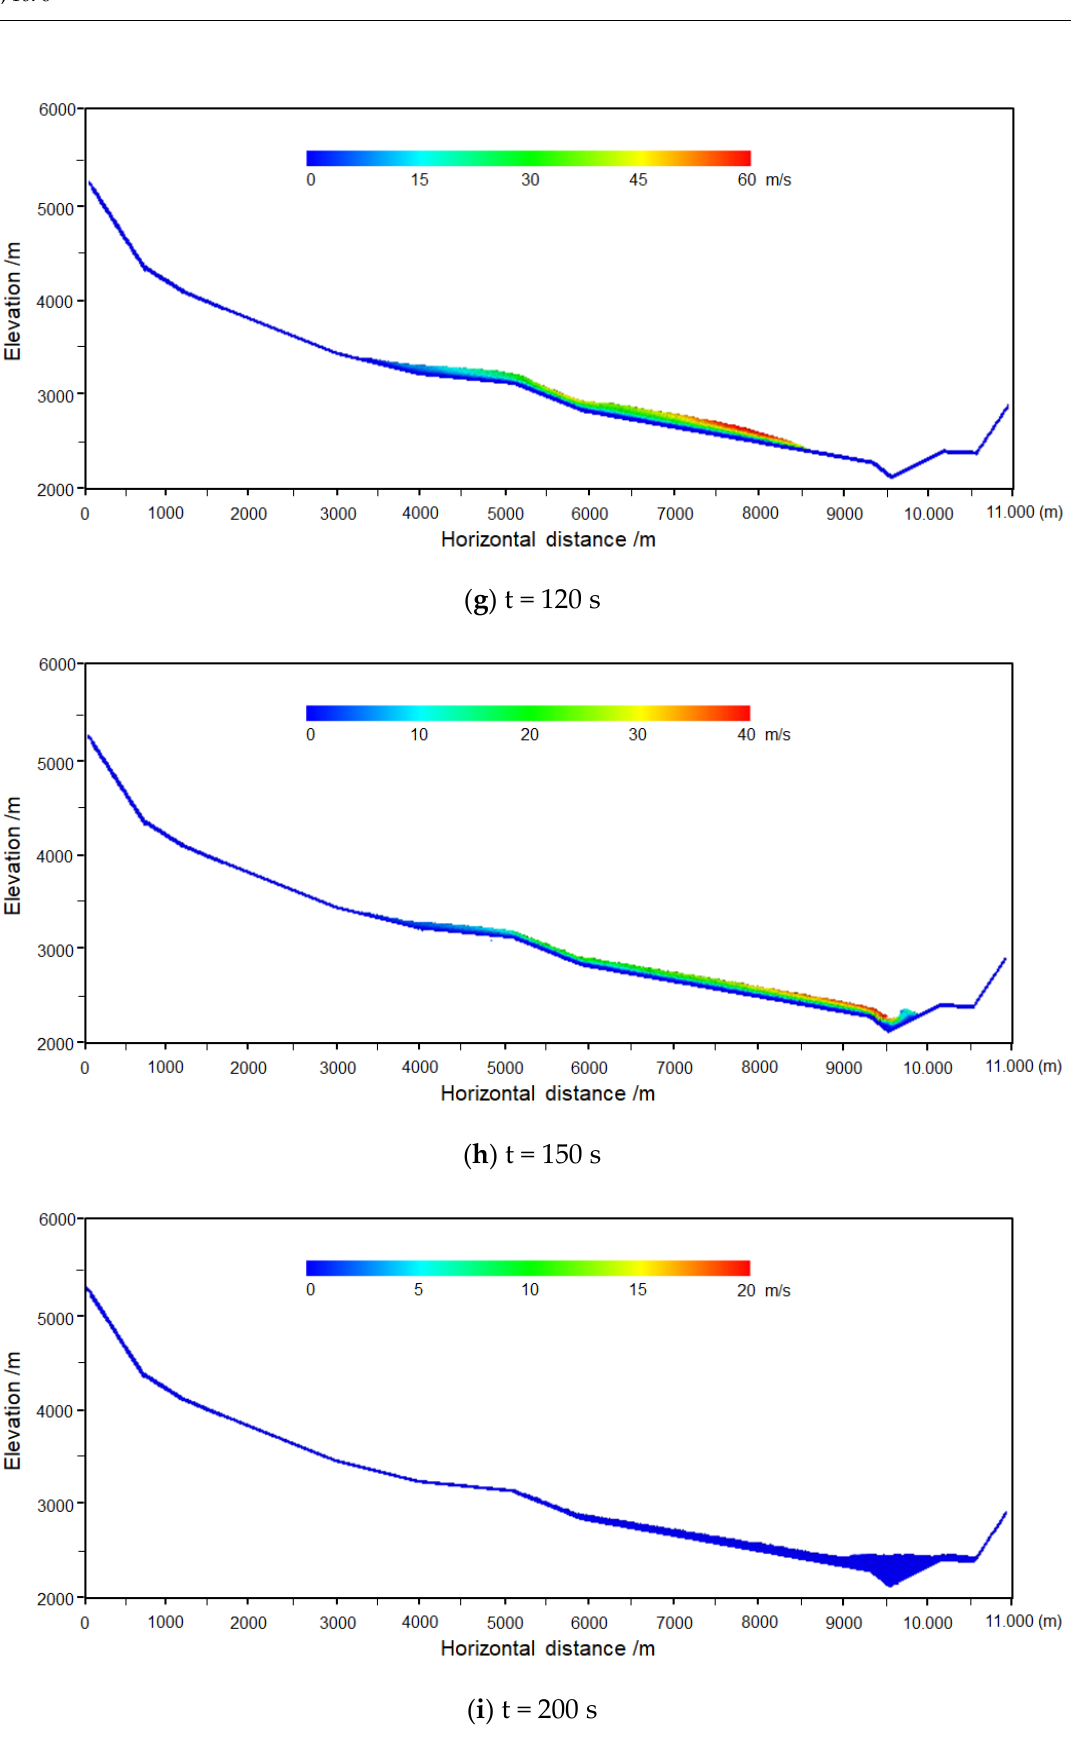
Figure 7. Two-dimensional simulated results for the motion process of the Yigong debris flow.